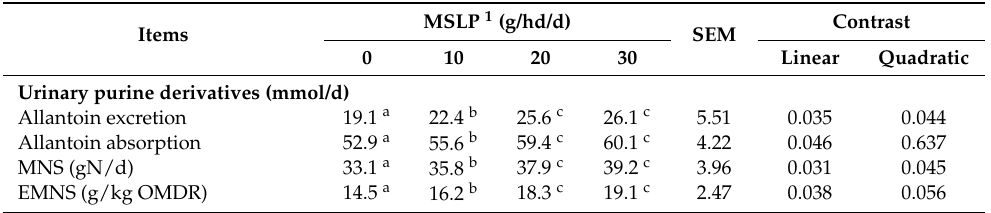
Table 5. Effect of Mitragyna speciosa Korth leaf pellet supplementation on urinary purine derivatives (PD) and microbial protein synthesis in Thai native beef cattle.